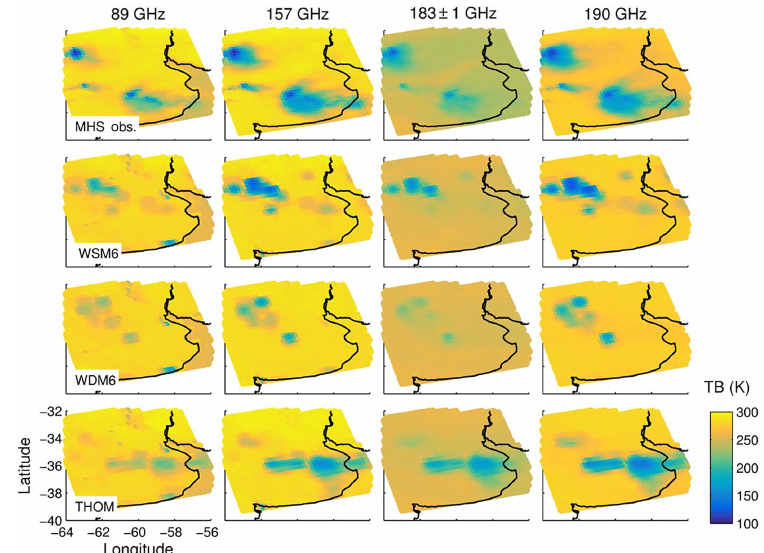
Figure 21. MHS observations, as compared to the corresponding radiative transfer simulations using the dendrite habits for the WSM6, WDM6 and THOM scheme simulations for the 23 January 2014 event